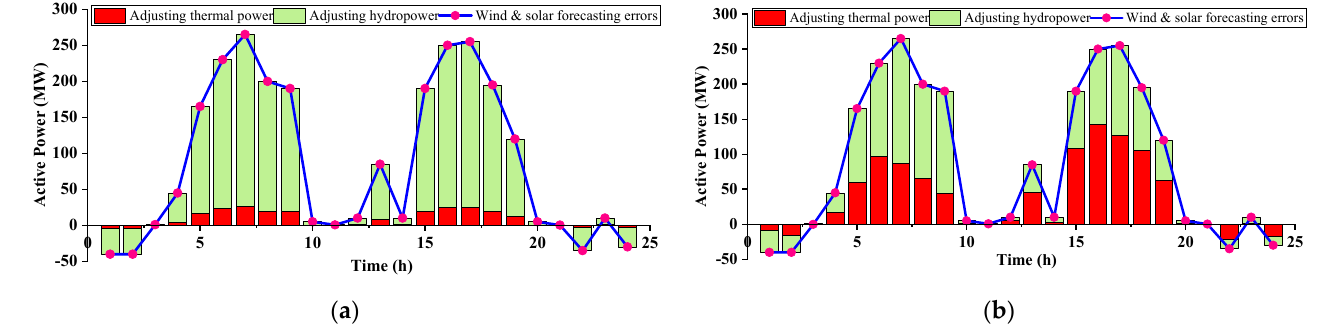
Figure 6. Total adjusting power of thermal power and hydropower with ( a ) TN-DOPF model and ( b ) DR-DOPF model.